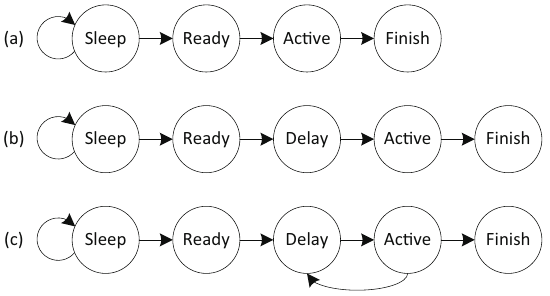
Figure 2. Different state diagrams of ( a ) uncontrollable, ( b ) non-interruptable, and ( c ) interruptable